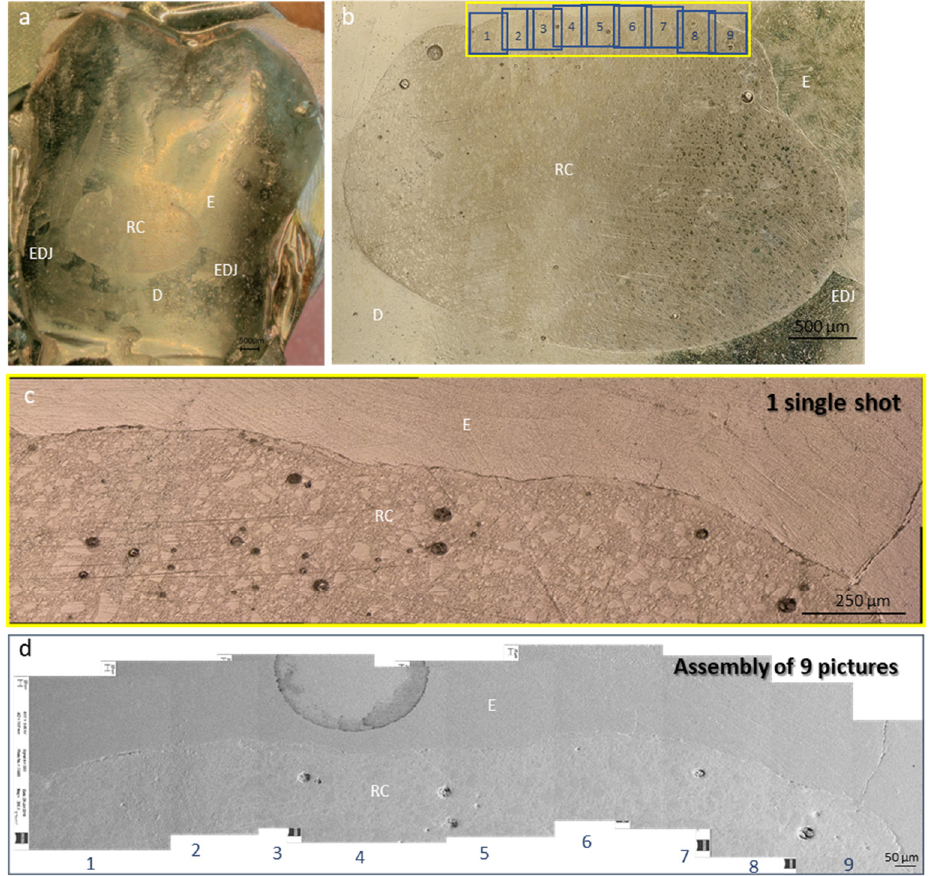
Figure 1. ( a ) Photograph of one the fifteen gold-coated tooth replicas with a class V composite restoration, ( b ) DOM image of the entire cavity at 50 × magnification and ( c ) a semiautomatically generated assembly at 200 × showing the enamel part in the yellow box. Only one capture